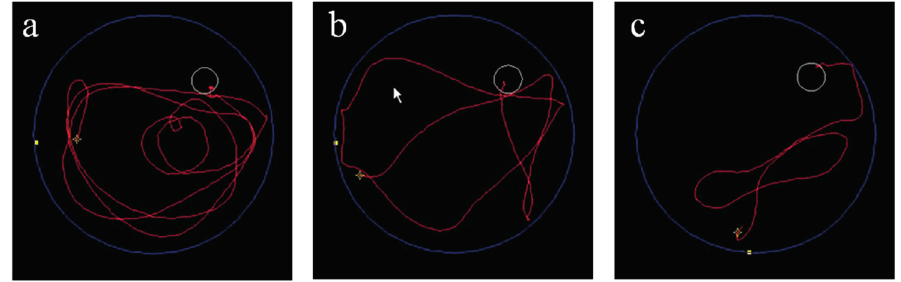
Figure 1. Escape latency of Senescence-Accelerated Mouse Prone 8 (SAMP8). ( a ) Untreated SAMP8; ( b ) SAMP8 treated with intra-bone marrow-bone marrow transplantation (IBM-BMT); and ( c ) SAM-resistant strains 1